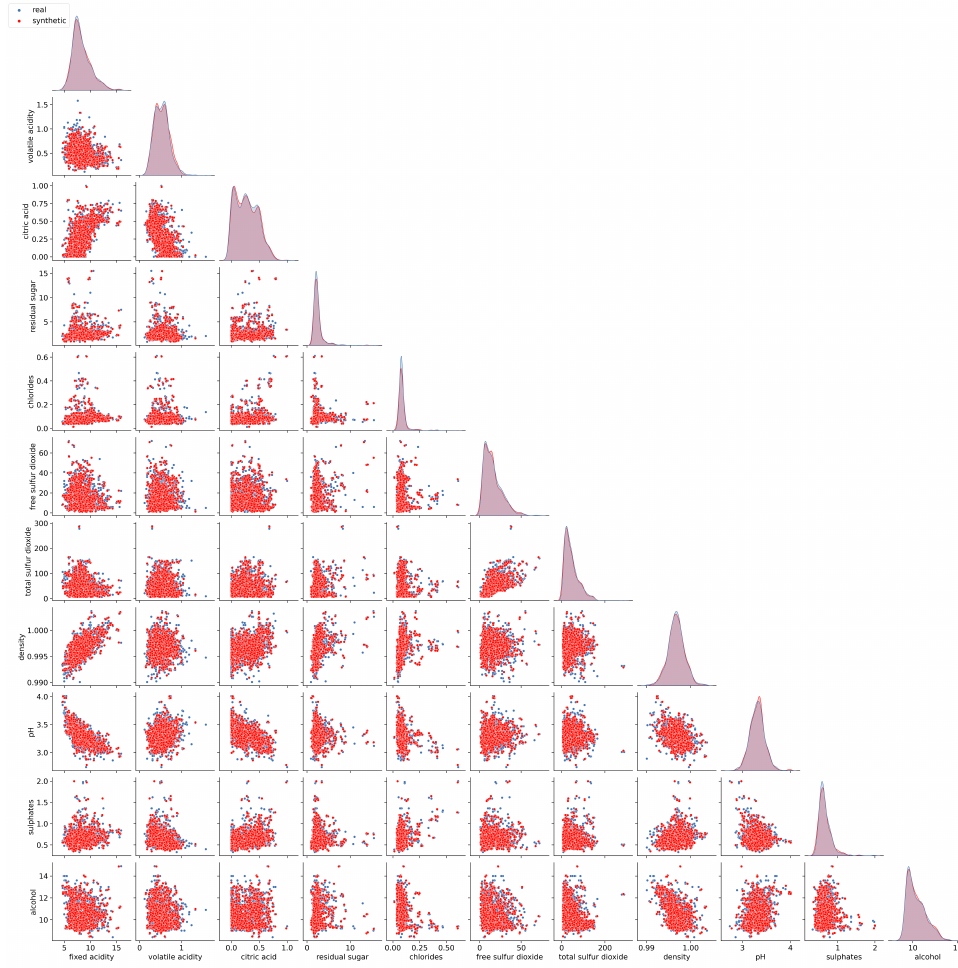
Figure 5. Scatter plots and density plots of the second group of experiments.